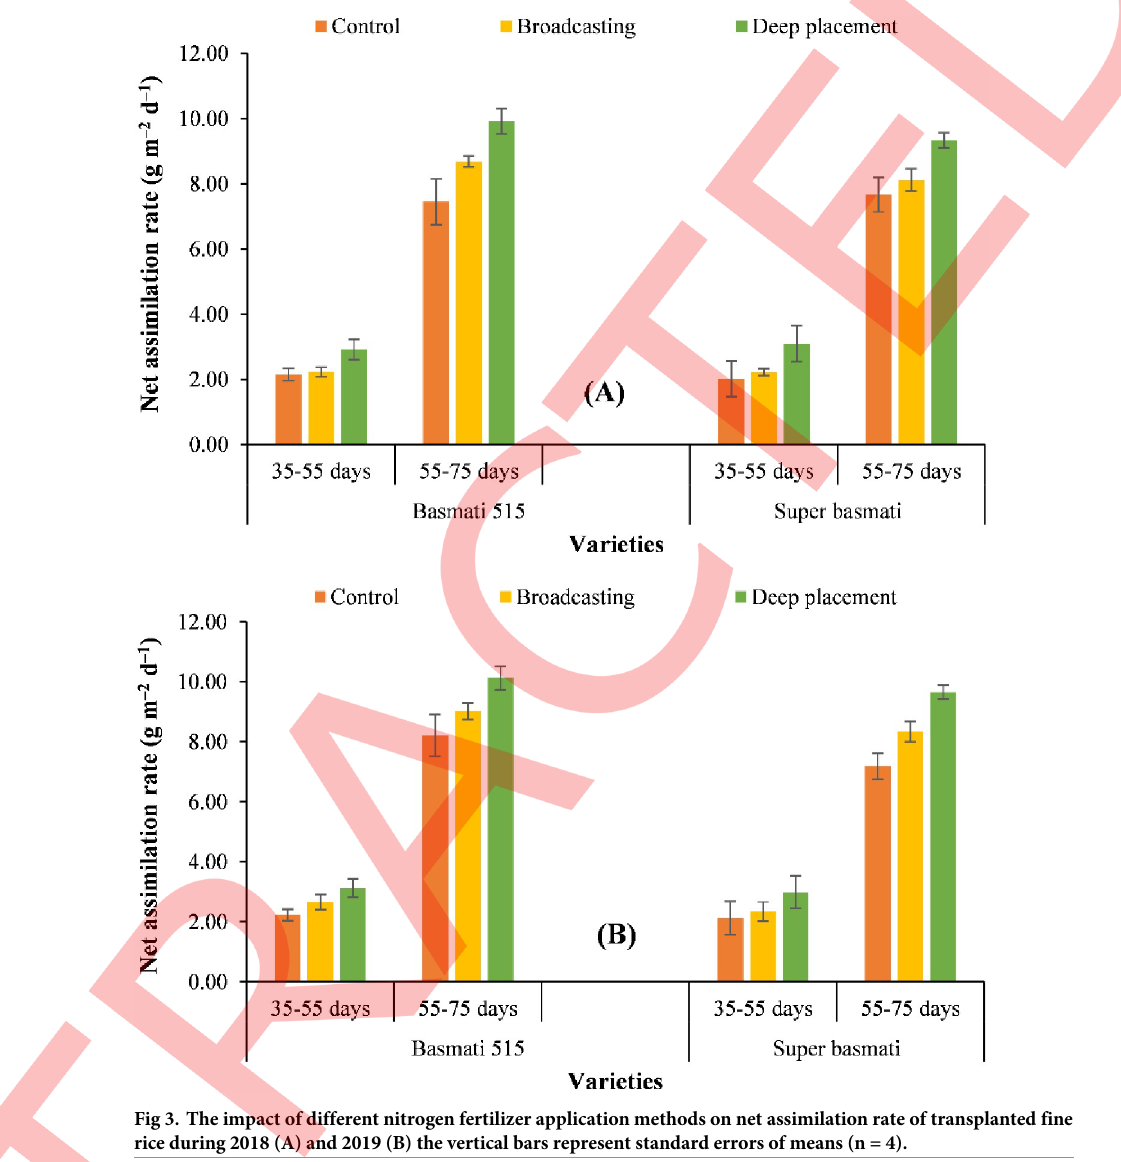
Fig 3. The impact of different nitrogen fertilizer application methods on net assimilation rate of transplanted fine rice during 2018 (A) and 2019 (B) the vertical bars represent standard errors of means (n = 4).